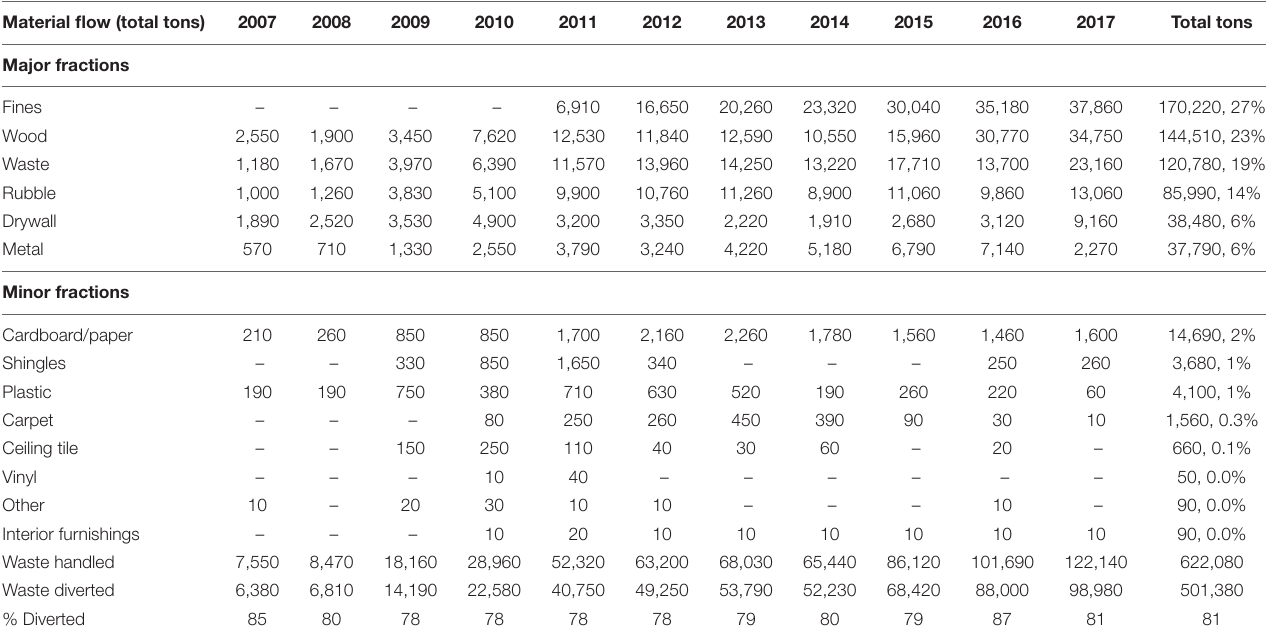
TABLE 1 | Summary of self-reported materials leaving